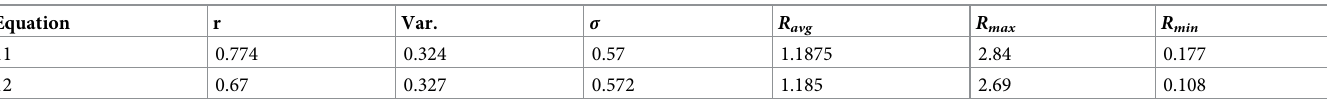
Table 5. Statistical results used in Eqs